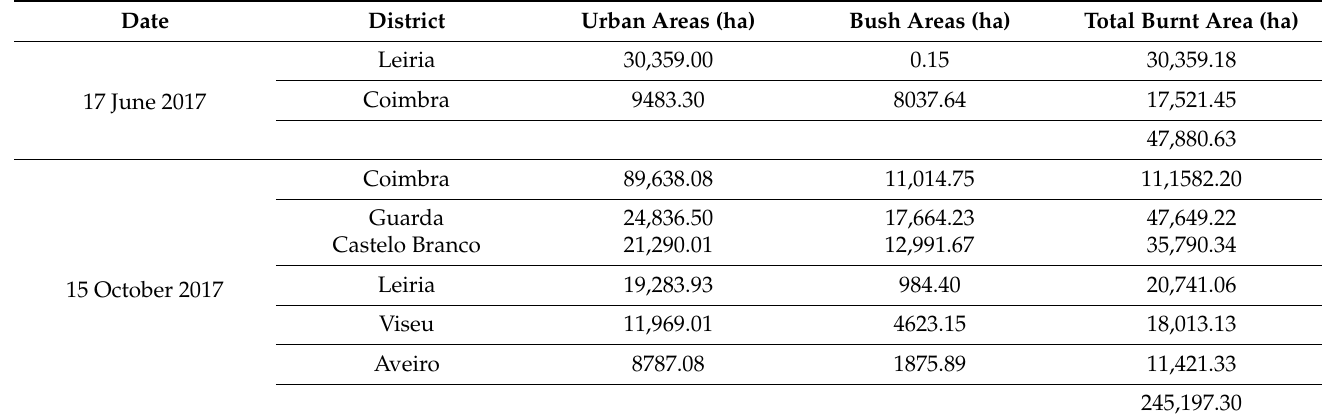
Table 5. List of the total burned areas (ha) by the district on 17 June and 15 October 2017 (only the major wildfires were considered) ([53,54] accessed on 1 February 2022).